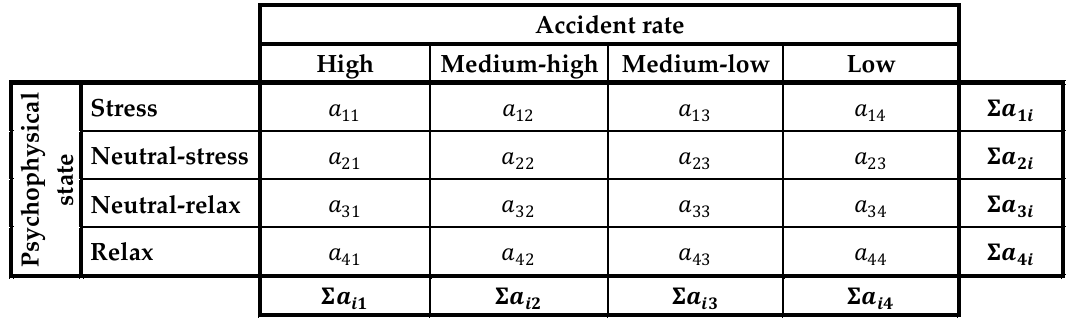
Figure 8. Example of correlation matrix, where a xy is the number of recorded correlations between psychophysical state and accident rate.